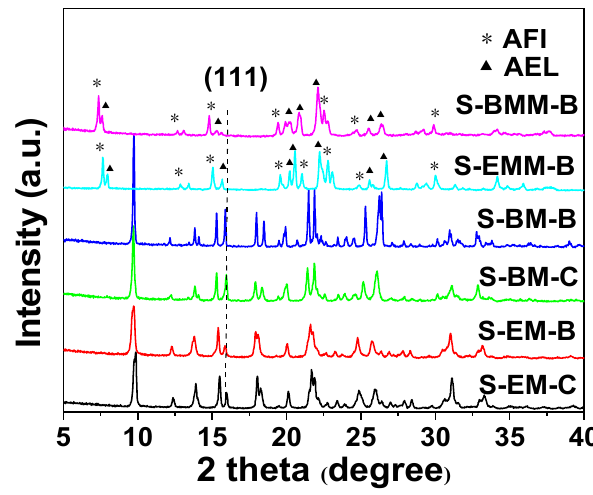
Figure 5. XRD patterns of samples synthesized with different ILs.